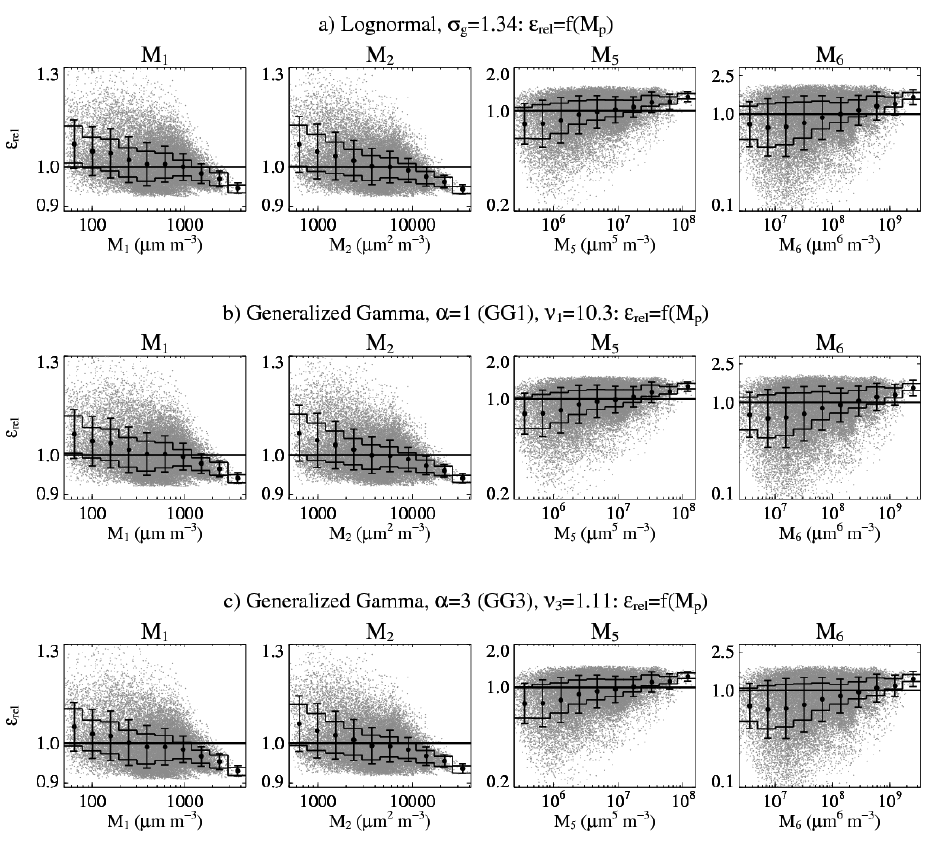
Fig. 4. Same as Fig. 3 for the relative errors. The circles and the error bars denote the geometric mean and the geometric standard deviation of the relative error value distribution in each moment class. The relative errors are not normalized.